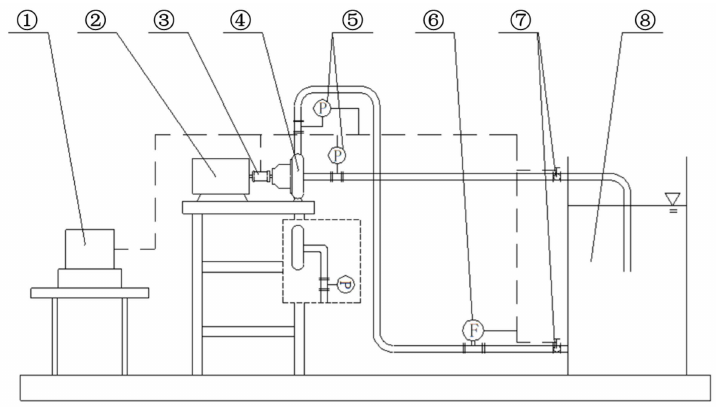
Figure 2. Schematic diagram of experimental